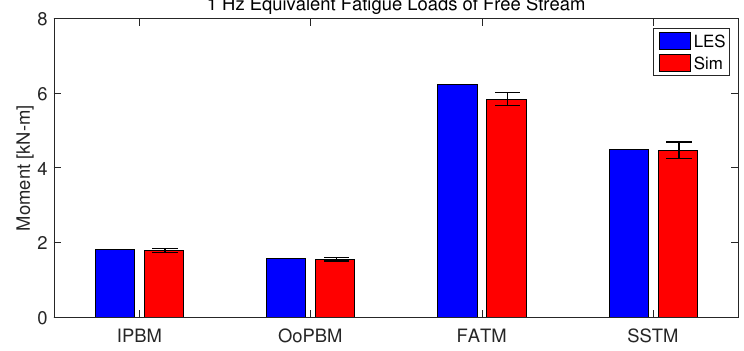
Figure 28. 1-Hz equivalent fatigue loads in the free stream based on LES and on stochastic